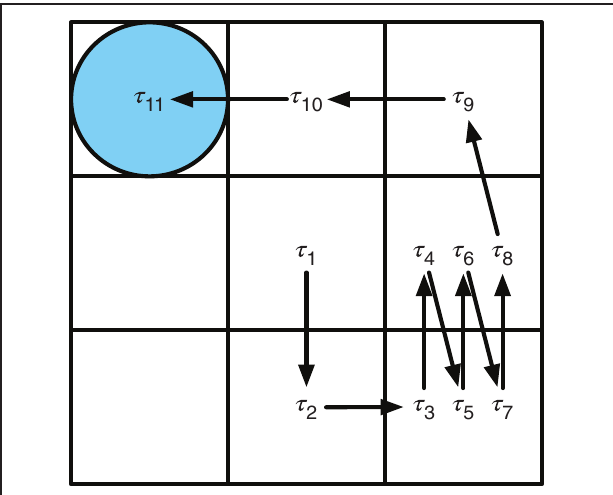
FIGURE 3 | This example movement in trial x illustrates how the intervals T x = (τ x 1 ,...,τ x 11 ) that are part of a wiggle movement are divided over the three types of locations. The goal location is the bottom-right square, the non-goal locations are the rest of the squares, and the adjacent location is the middle-right square. This means that G x = (τ x 3 ,τ x 5 ,τ x 7 ) , N x = (τ x 2 ,τ x 4 ,τ x 6 ,τ x 8 ,τ x 9 ,τ x 10 ) , and W x = (τ x 4 ,τ x 6 ) , as explained in sections 4.1 and